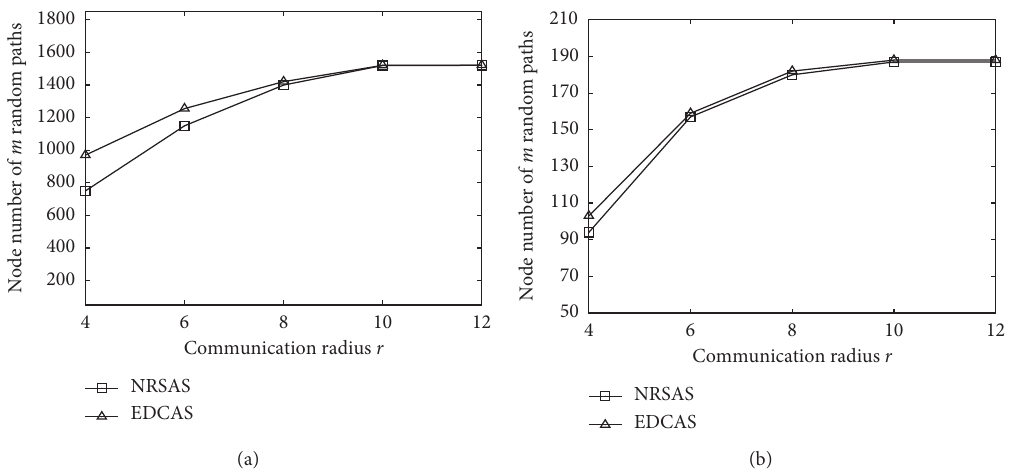
Figure 15: The effect of the communication radius on the random path. (a) Synthetic dataset. (b) IntelLab dataset.